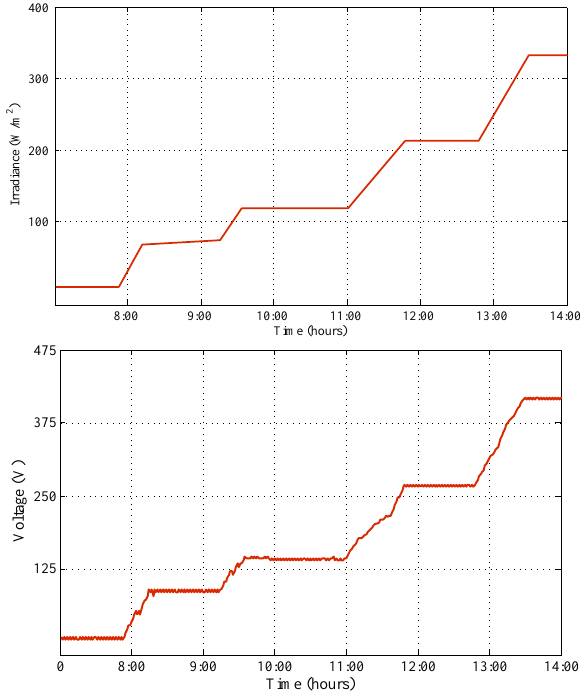
Figure 12. Changing DC bus voltage, corresponding to the PV generated power, with respect to change in solar irradiation.